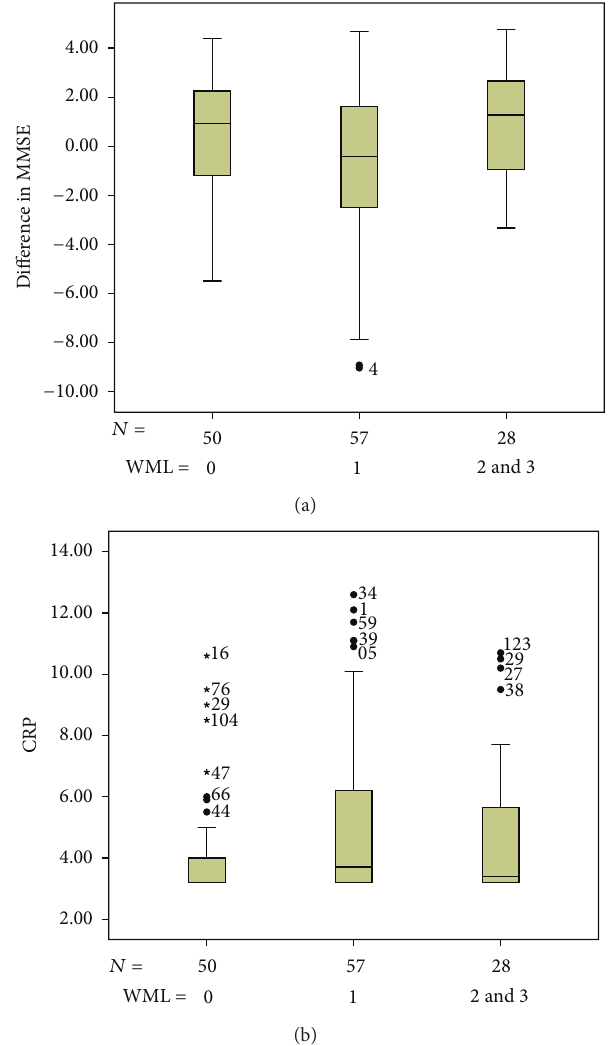
Figure 1: ANOVA between groups using a linear term; (a) 𝑃 : 0.470 (b) 𝑃 : 0.200. CRP: C-reactive protein; MMSE: Mini Mental Status Examination; WML: white matter lesions; 0: no lesions; 1: isolated hypodensities; 2: initially confluent hypodensities; 3: diffuse and extense hypodensities.